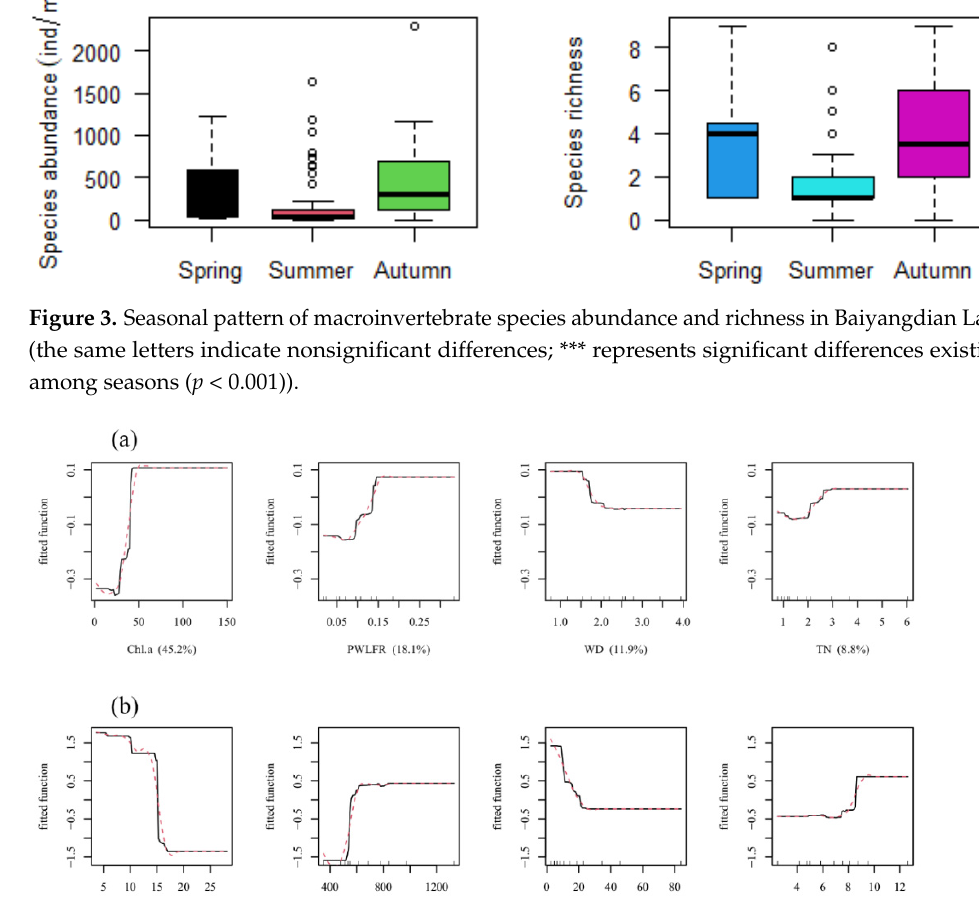
Figure 4. Partial dependence plots for BRT analyses relating macroinvertebrate species abundance (log 10 (x + 1) transformation) to the top four most important habitat variables in ( a ) summer and ( b ) spring and autumn. The relative influences of each variable in percentage are shown on the x -axis. The y-axes are on the log 10 (x + 1) scale and are centered on zero as the over the data distribution. Chl a : Chlorophyll a ; PWLFR: The percentage of water level fluctuation range; WD: Water depth; TN: Total nitrogen; WT: Water temperature; TDS: Total dissolved solids; DO: Dissolved